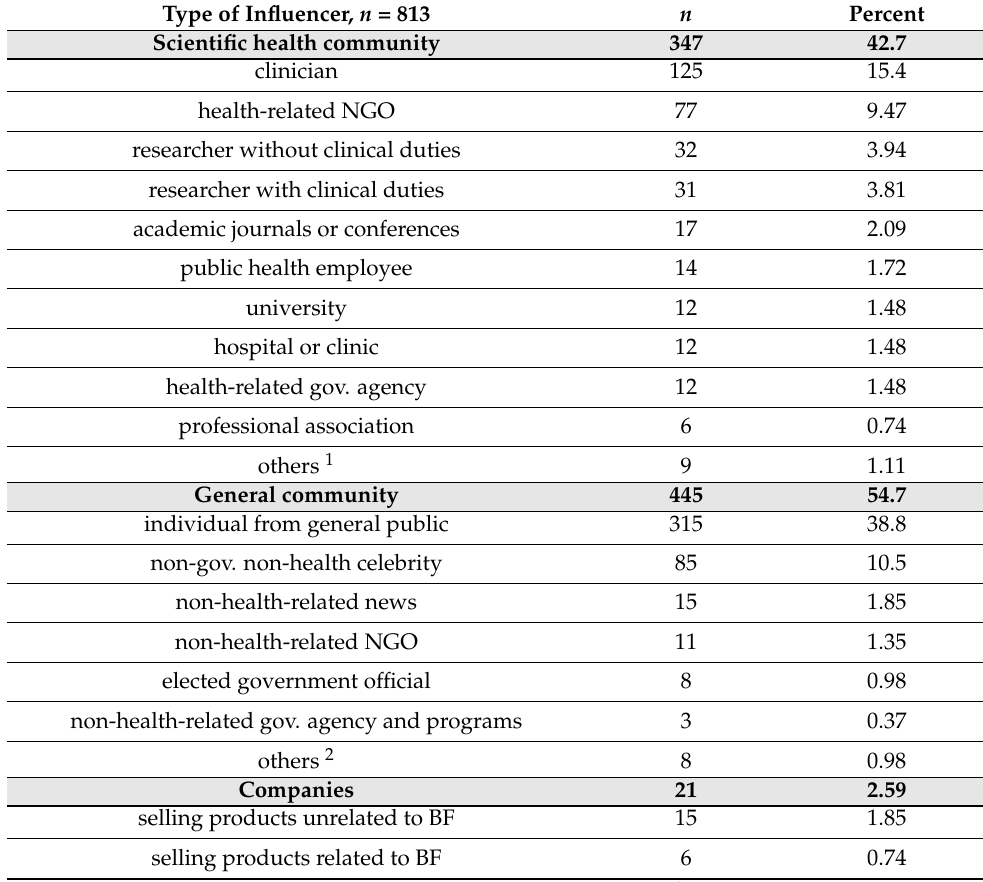
NGO, non-governmental agency. Gov, governmental. BF, breastfeeding. 1 Such as account for a continuing medical education (CME) course. 2 Such as an account for a comedy show. Gray categories indicate the three broad coded influencer groups.